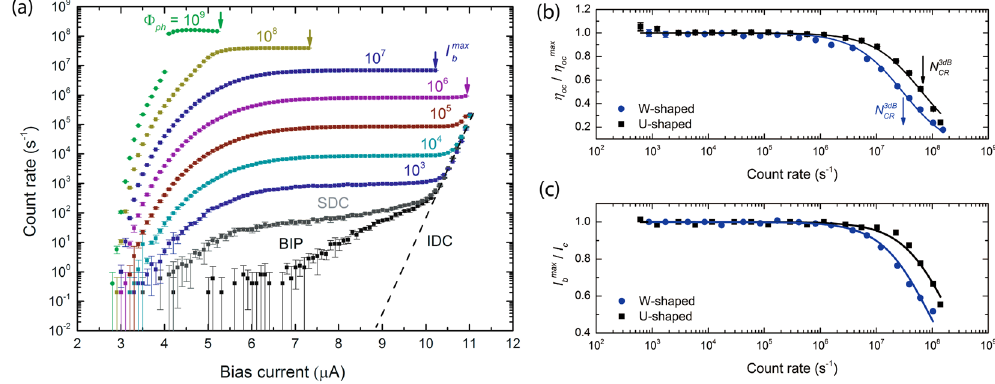
Figure 3. Measurement of the single-photon detector (SNSPD) performance. ( а ) Count rate of the W-shaped nanowire vs bias current, at different levels of optical power at 1550 nm wavelength. The photon flux is shown above each curve and marked by individual colors. The count rate when the laser is turned off but connected to an optical fiber at a room temperature is marked by SDC. The count rate with a closed metal cup is marked as BIP. The intrinsic dark counts marked as IDC ( b ) Dependence of the normalized on-chip detection efficiency ( η oc ) on count rate. The black squares correspond to the measured data for U-shaped nanowire, while the blue dots for W-shaped nanowire. The fitted values are represented with solid lines and the arrows indicate the count CRdB 3 max ( с ) Normalized maximum current vs count rate. The black squares rate N CRdB 3 at which η η = . N ( ) /2 oc oc represent the measured dependence for U-shaped detector, while the blue dots for the W-shaped detector. The fitted values are represented with solid